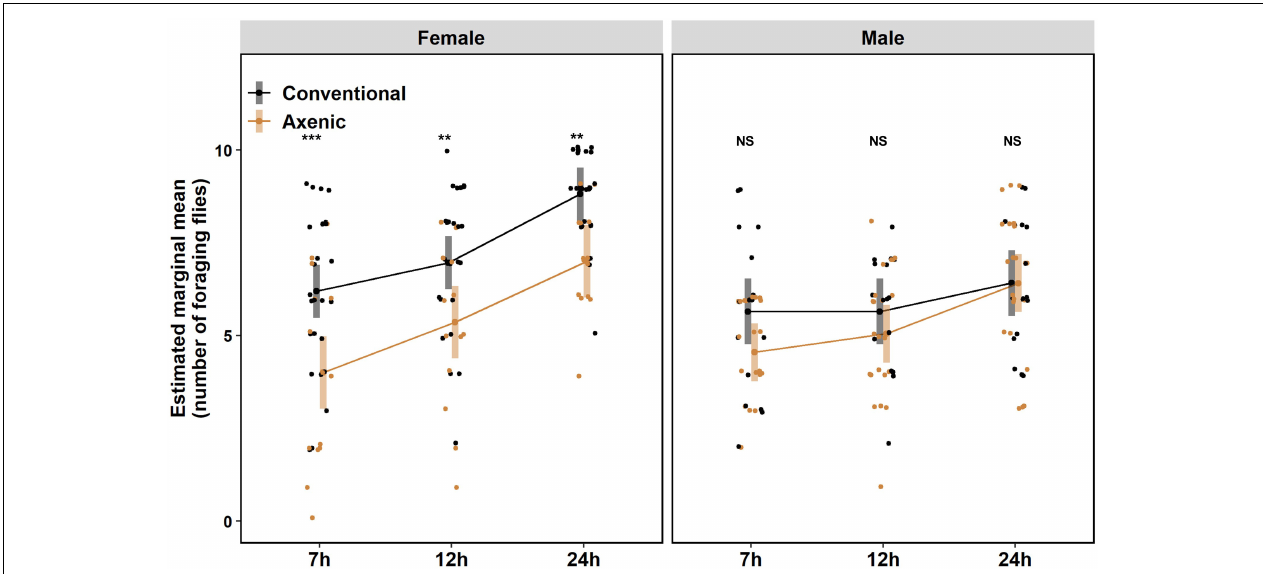
FIGURE 1 | Foraging of adult Drosophila suzukii on fruit-based foods. Conventional females, N = 26; Axenic females, N = 14; Conventional males, N = 17; Axenic males, N = 22 ( N indicates the number of arenas). The numbers of flies foraging on food (foraging flies) at 7, 12, and 24 h were scored. The data were analyzed by fitting a linear mixed effects model (LMM) with time, microbiome status, and sex as fixed effects (and their interactions tested), while arenas and days were accounted for as random effects. Error bars represent estimated marginal means (EMMs) with 95% confidence interval. The observed number of foraging flies in each arena was represented in dots. Statistical significance between conventional and axenic flies is indicated with * P < 0.05, ** P < 0.01, *** P < 0.001. NS represents no statistical significance ( P ≥ 0.05). P -values were adjusted by Bonferroni